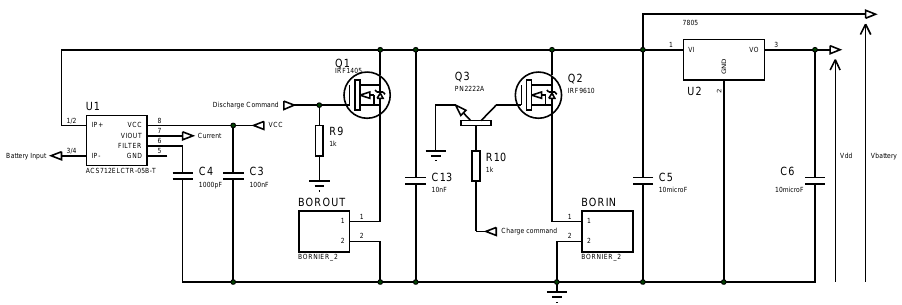
Figure 4. Electronic circuit diagram for power regulation, current measurement and energy control.